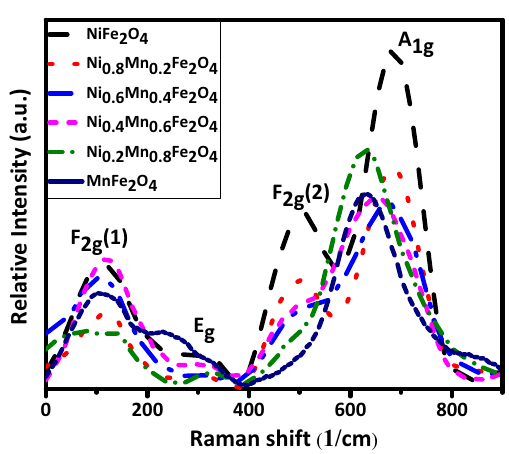
Figure 3. Raman spectra of the Ni 1−x Mn x Fe 2 O 4